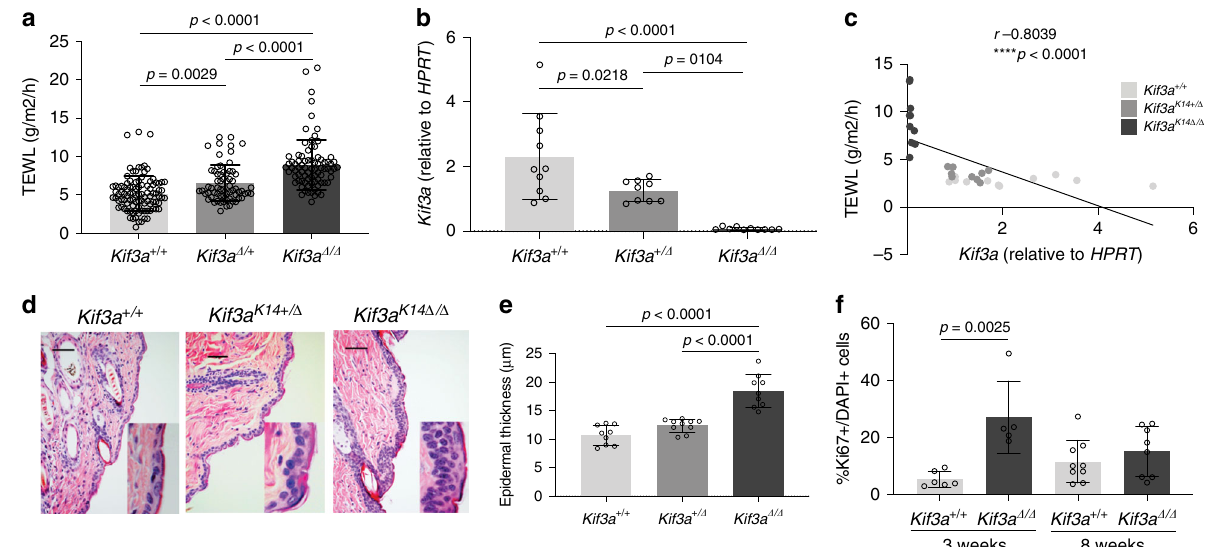
Fig. 3 Kif3a K14 Δ / Δ mice develop disrupted skin barrier. a Trans-epidermal water loss (TEWL) was measured in Kif3a + / + , Kif3a Δ / + and Kif3a K14 Δ / Δ mice, age 6 – 10 weeks ( n = 284 biologically independent animals examined over three independent experiments). b RNA isolated from Kif3a + / + , Kif3a Δ / + ,